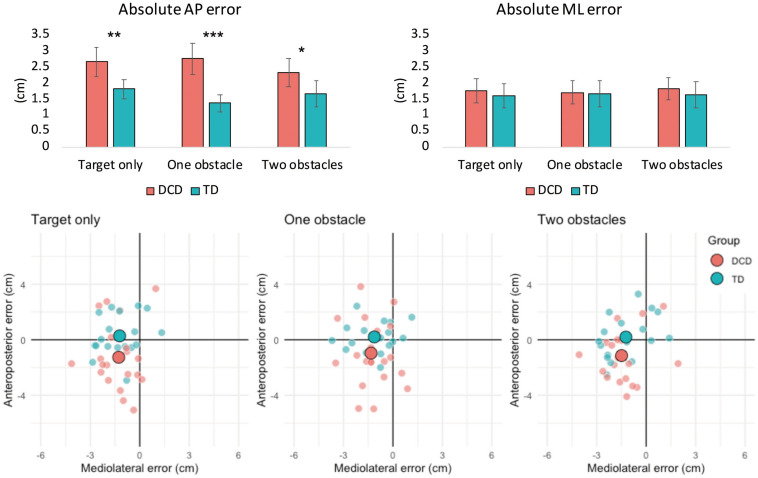
Bar charts (top) representing mean (± 95% CI) absolute foot placement error in both the anteroposterior (left) and mediolateral (right) directions of movement. Asterisks signify between group differences at the < 0.05 (*), 0.01 (**), and 0.00 (***) levels. Constant foot placement error (bottom) for the DCD and TD groups for the target only, one obstacle and two obstacle task conditions. The large data points represent the group means, whilst the smaller data points represent the mean values of individual participants. Negative values on the horizontal and/or vertical axes indicate that the foot was positioned medial and/or posterior of the target center, respectively.